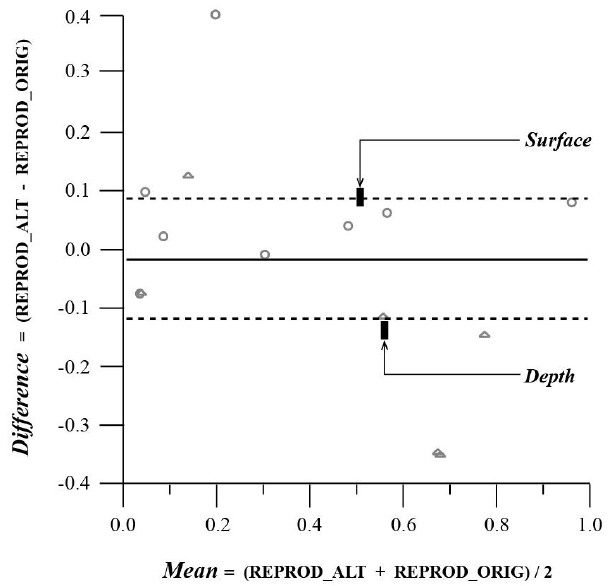
Figure 6. (Alt.) Matched Pairs Comparison on Copy Exercise: Reproductions in Original versus Altered Drawings grouped by Plastic Values (Ambiguous